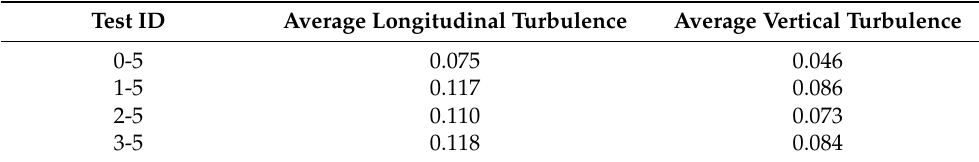
Table 2. The average longitudinal and vertical turbulence intensity for cases 0-5, 1-5, 2-5, and